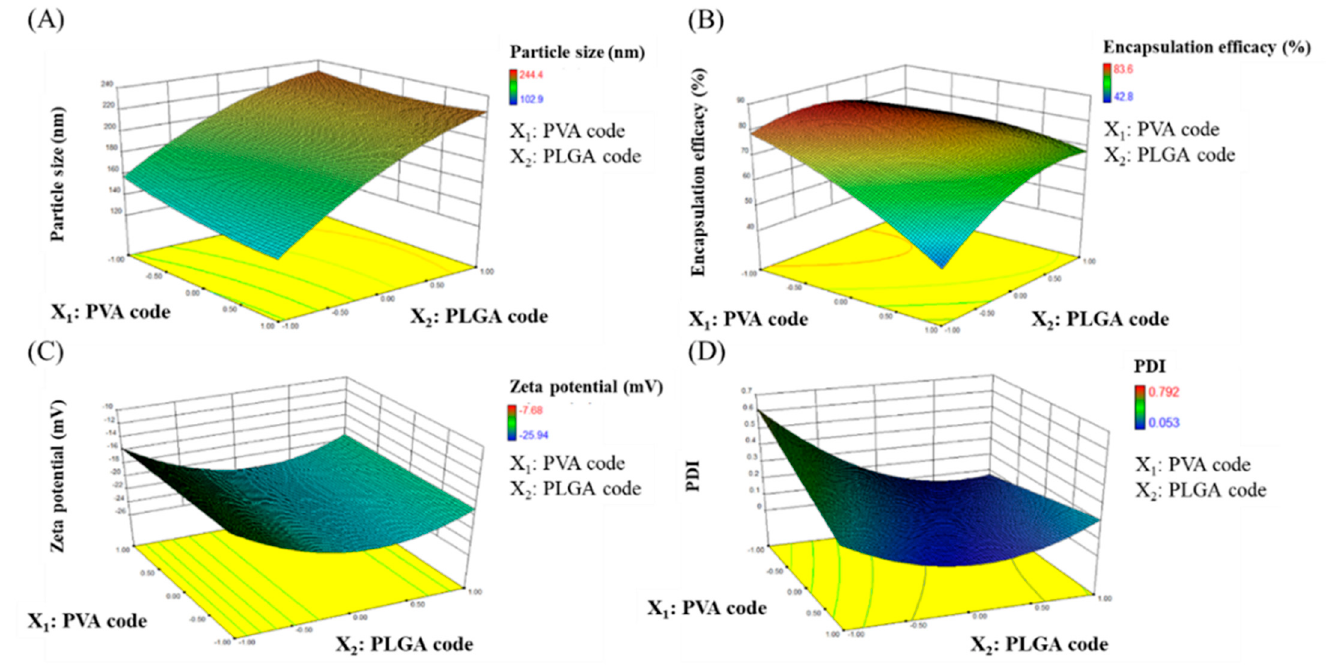
Figure 3. Response surface plots of PVA concentration (X 1 ) and amount of PLGA (X 2 ) for ( A ) particle size (Y 1 ), ( B ) encapsulation efficiency (Y 2 ), ( C ) zeta potential (Y 3 ), and ( D ) PDI (Y 4 ) analysis.